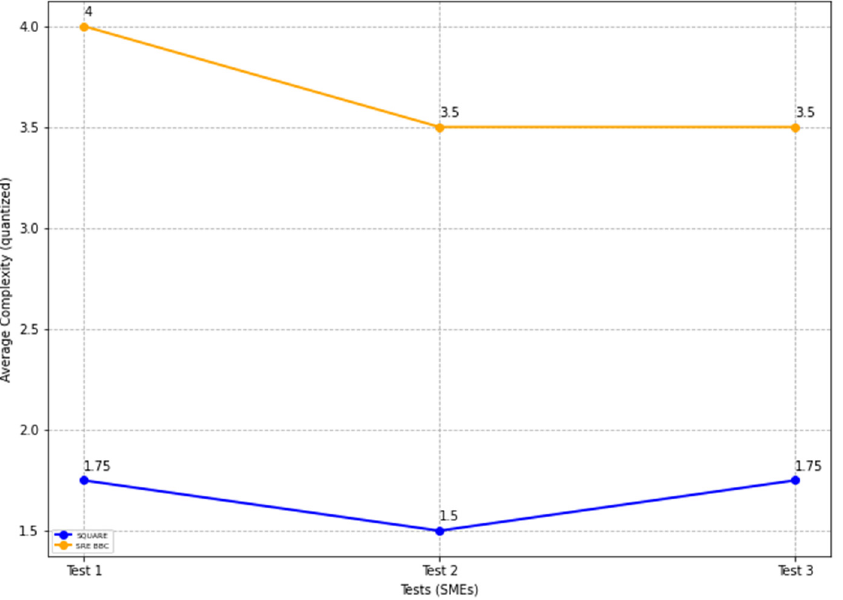
Figure 16. The comparison of quantified complexity level score for SQUARE and SRE_BBC (Feasibility Study).